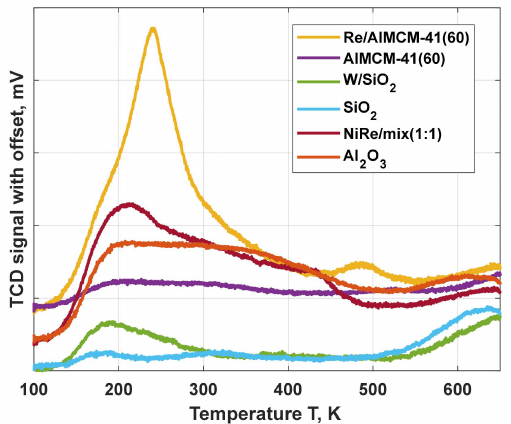
Figure 4. NH 3 -TPD profiles of the applied catalysts for the metathesis of ethene and trans-butene. Both, Re/AlMCM 41 (60) and NiRe/mix (1:1) catalysts indicated not only low tem- perature peaks or shoulders at 200 ◦ C but also a broad peak up to 400 ◦ C. Further,